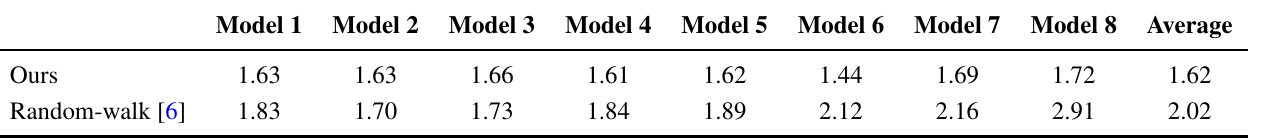
Table 1. Comparison of stretch